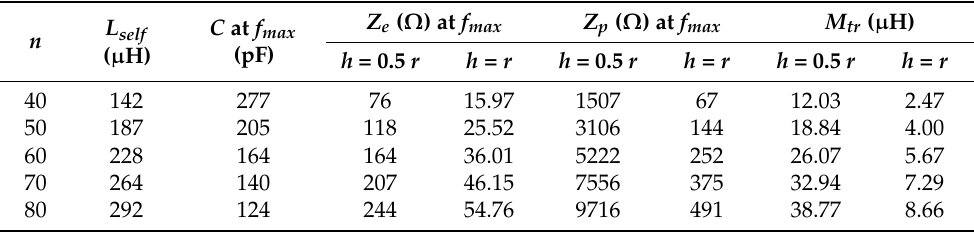
Table 7. Self and mutual inductances as well as compensating capacities and load impedance (at f max ) for square coils and r = 25